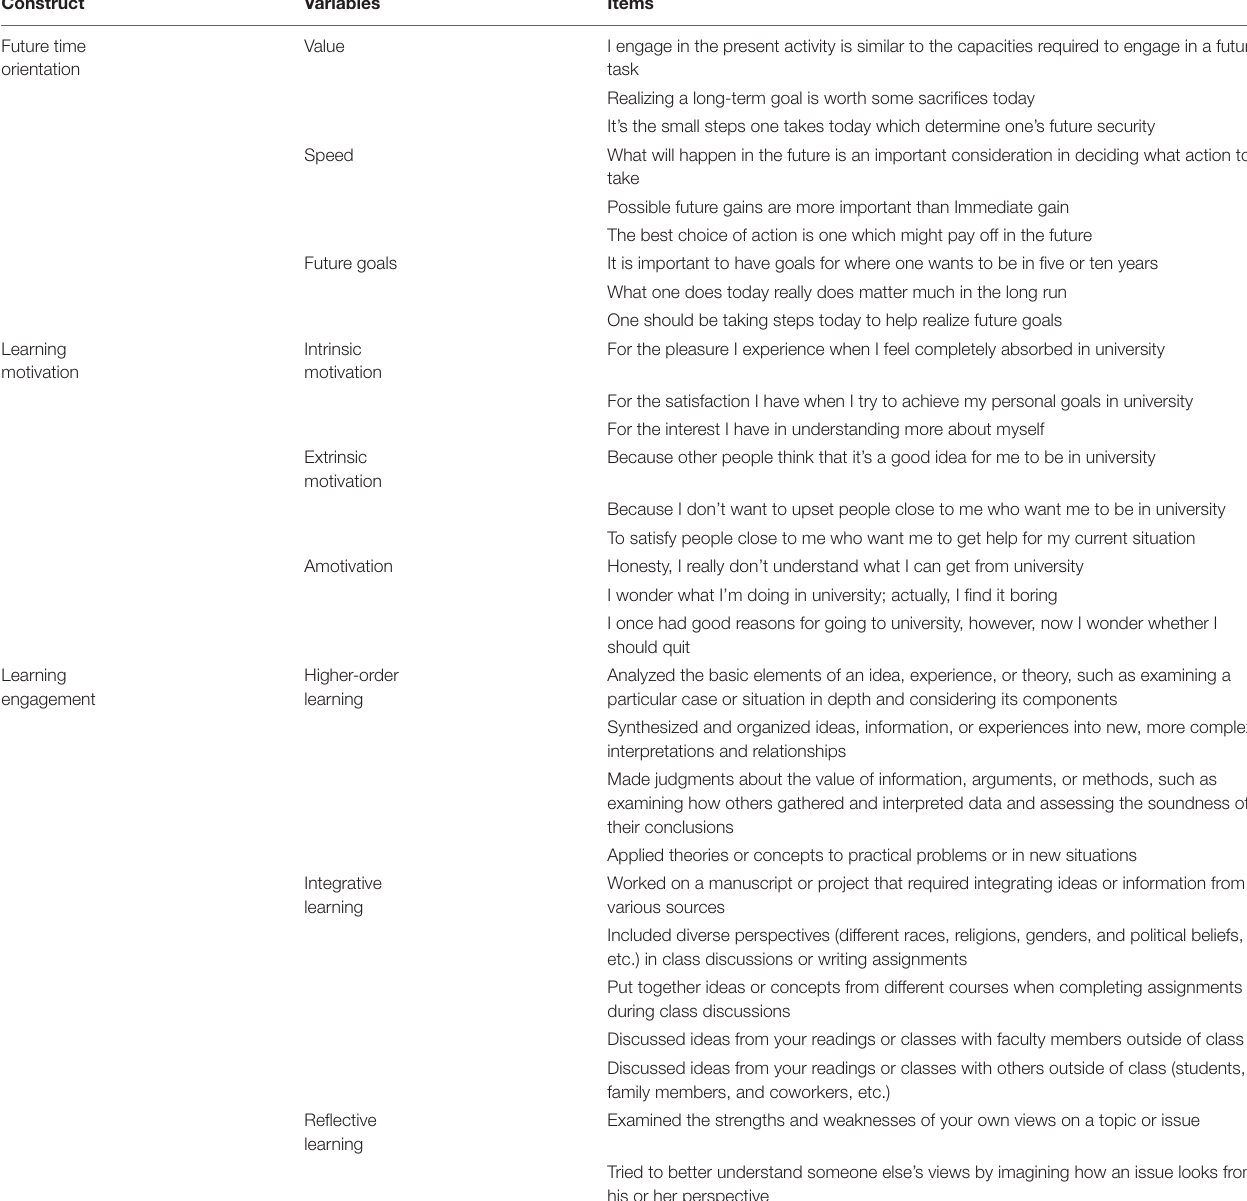
TABLE 1 | Scale of measure variables. Construct Variables